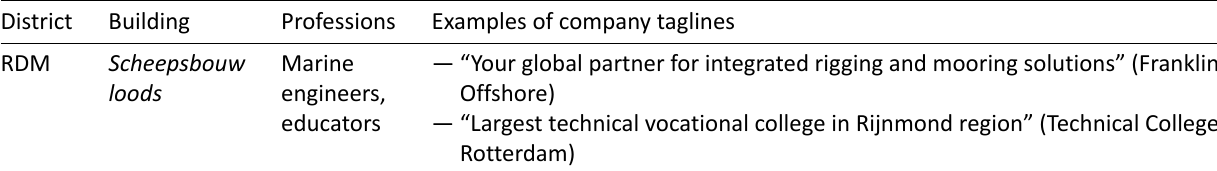
Table 2. (Cont.) Overview of users in Makers District key